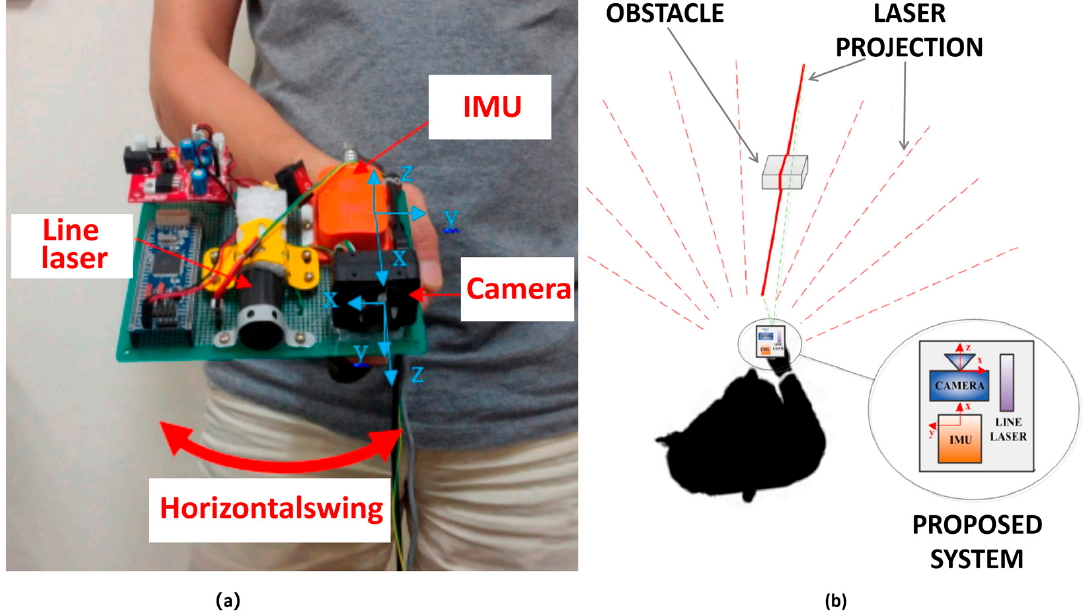
Figure 5. ( a ) Smart cane composed of camera, linear laser and IMU; ( b ) Working diagram of the smart cane system